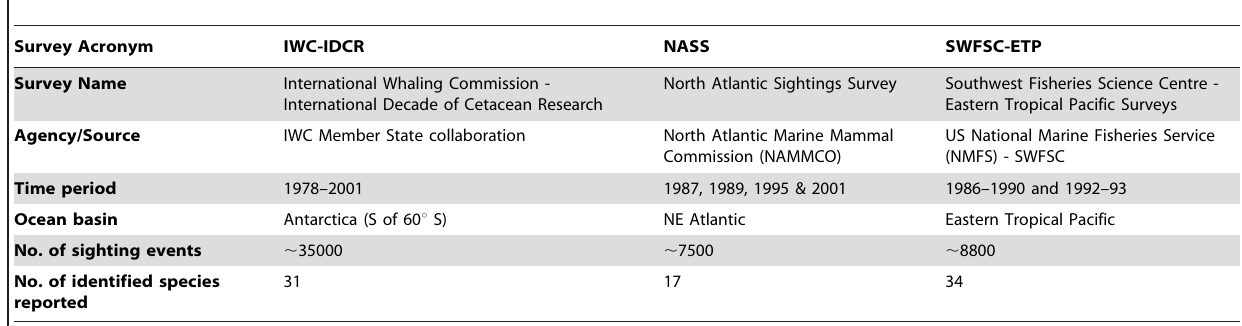
Table 1. Summary of validation data